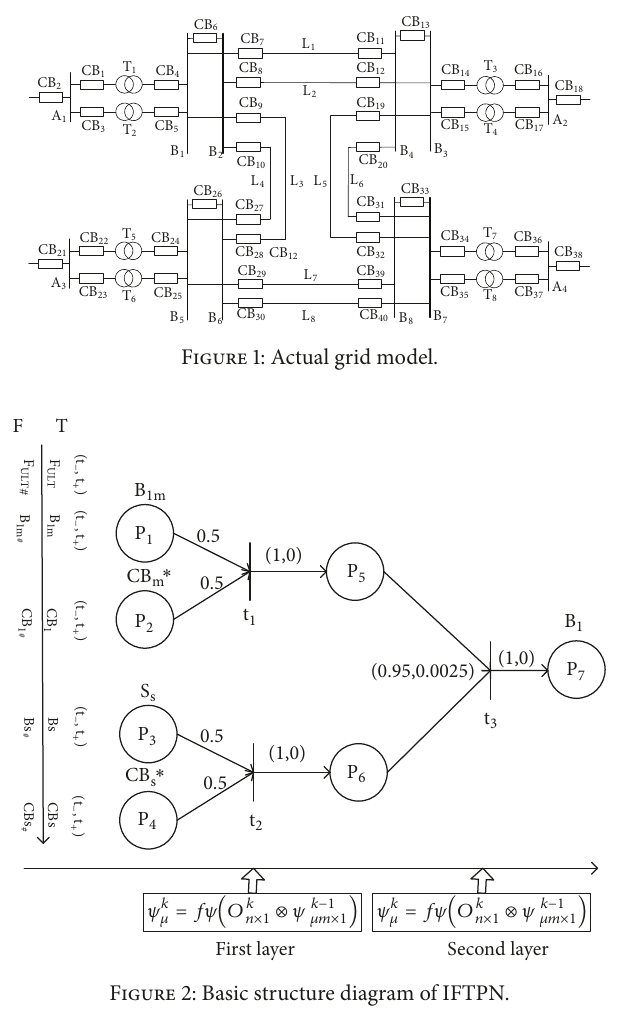
Figure 2: Basic structure diagram of